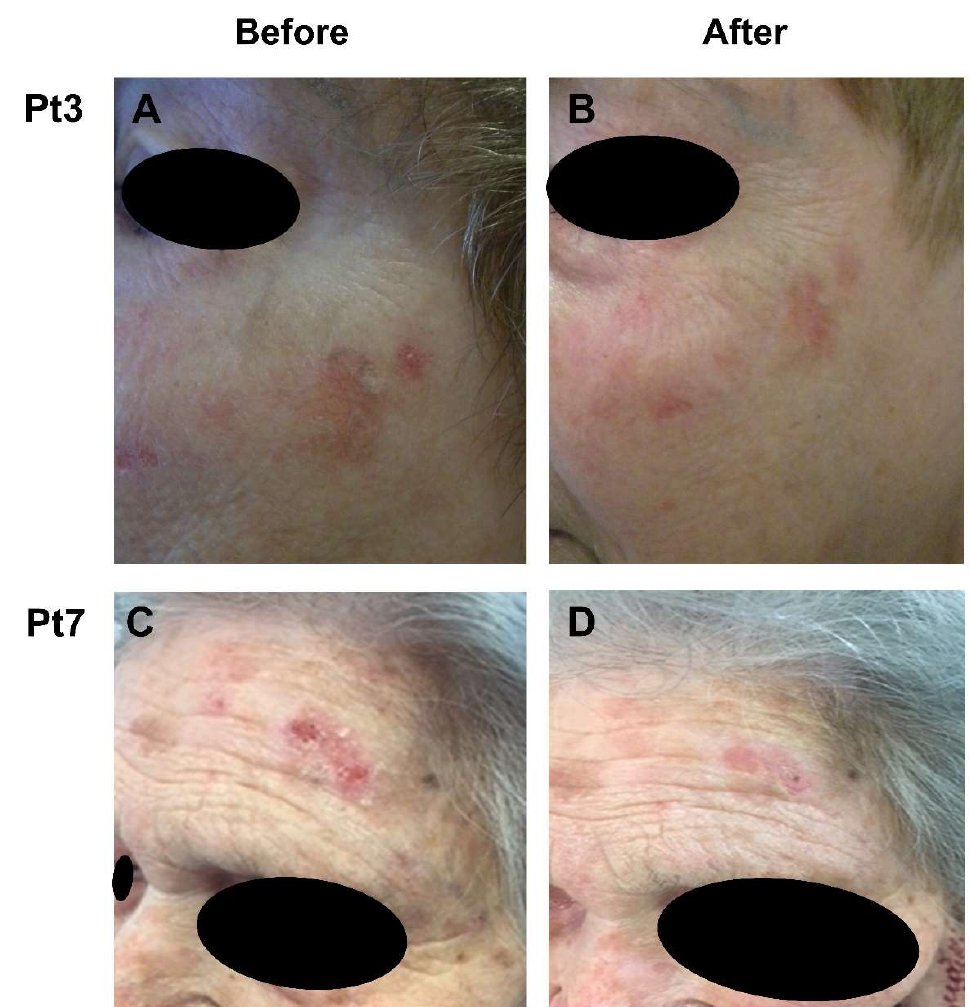
Figure 1. Comparing outcomes of conventional photodynamic therapy (PDT) using 630 nm 37 J/cm 2 illumination ( A , B ) and daylight PDT ( C , D ) in patients with actinic keratosis (AK). Clinical photographs before ( A , C ) and 12 weeks after ( B , D ) treatment with a single application of 5-aminolevulinic acid patch. ( A , B ): Patient 3, left cheek, complete response. ( C , D ): Patient 7, left temple, partial response.